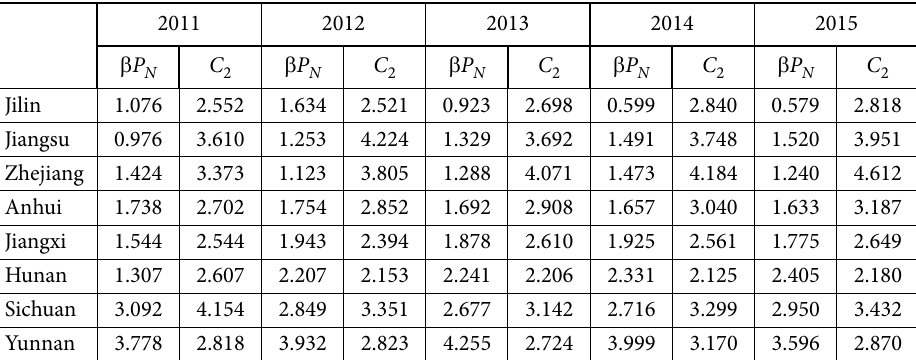
Table 7. C 2 and β P N in the selected